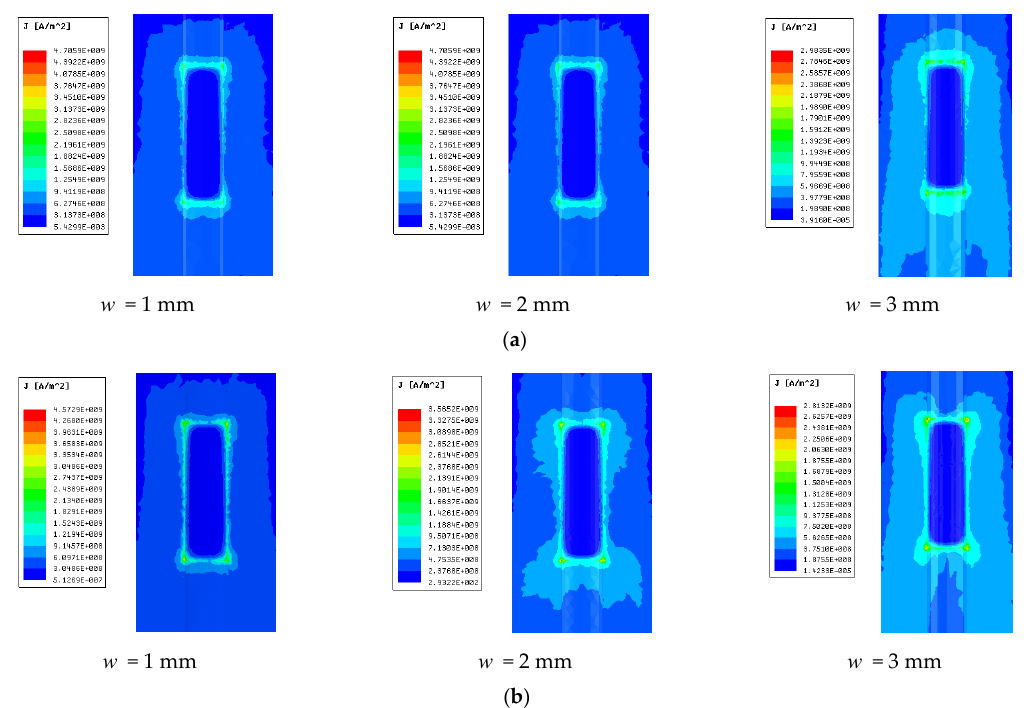
Figure 7. Distribution of orbital current density with different concave (convex) values: ( a ) convex elliptical rail; ( b ) concave oval rail